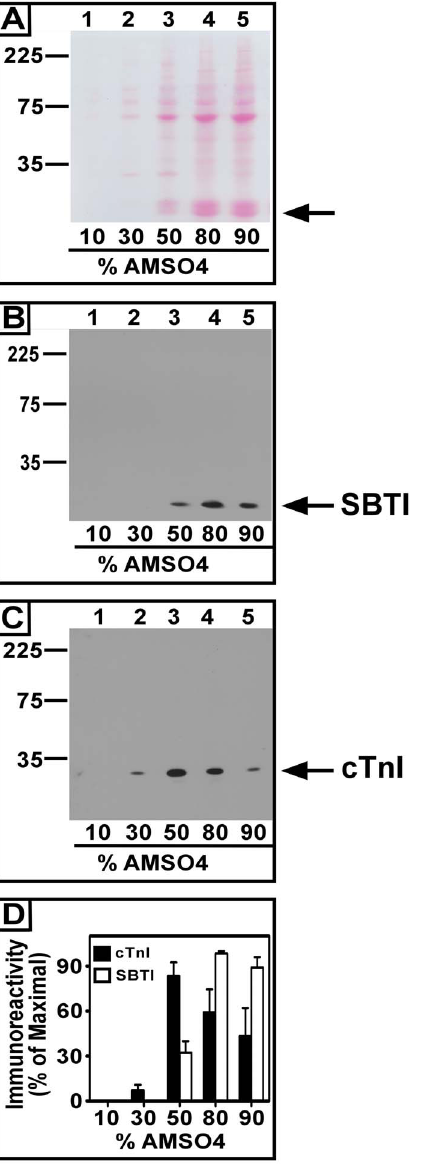
Figure 2. Optimization of ammonium sulfate (NH 4 ) 2 SO 4 precipitation of cardiac troponin I (cTnI) and the utility of